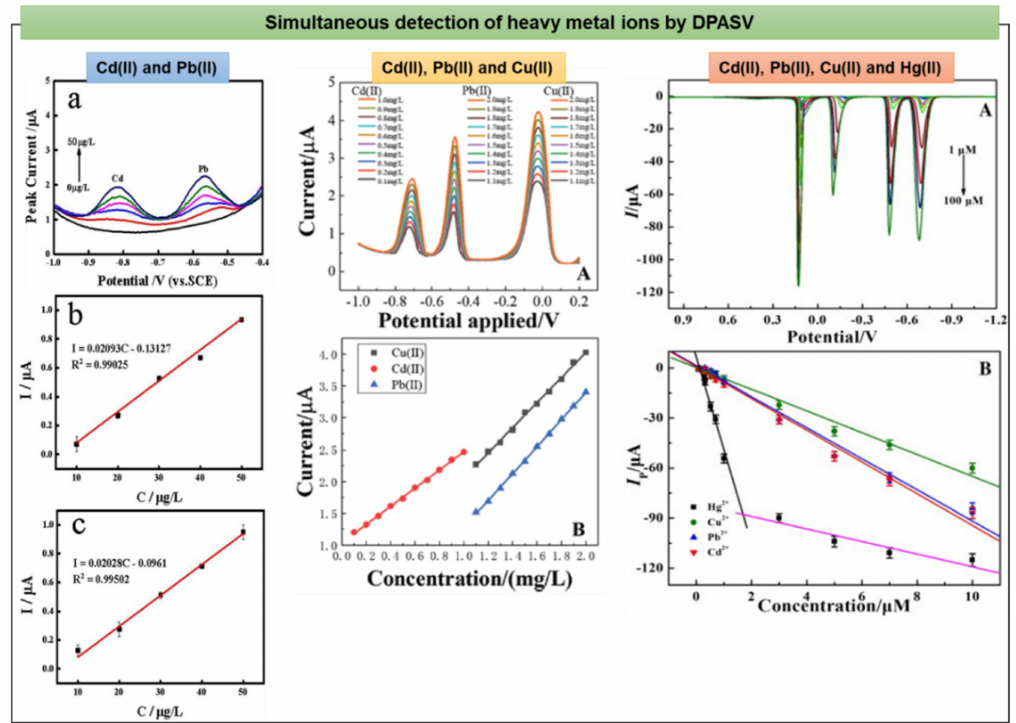
Figure 12. Di ff erential pulse anodic stripping voltammetry (DPASV) curves of bismuth oxycarbide for the simultaneous detection of Cd(II) and Pb(II) ( a -top left) [231]; thiacalix [4] arene-modified glassy carbon electrode for the simultaneous determination of tree HMIs ( b -top middle) [232]; Hydroxyapatite-Nafion for the simultaneous detection of four HMIs ( c -top right) [233]. The calibration curves are presented in ( b ) and ( c ) under the respective DPASV